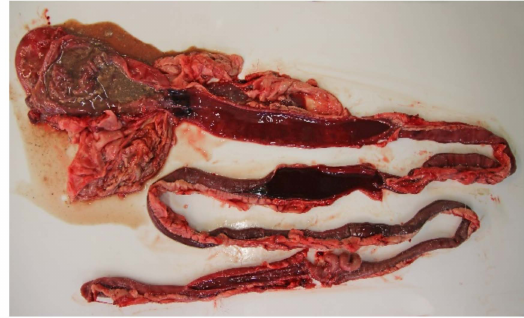
Figure 3. Gastrointestinal tract from a dog with acute haemorrhagic diarrhoea. The stomach content was brown and watery, and there was brown-red discoloration of the gastric mucosa. In both the small and large intestine, the mucosa was dark red and there was sparse blood-stained fluid content.